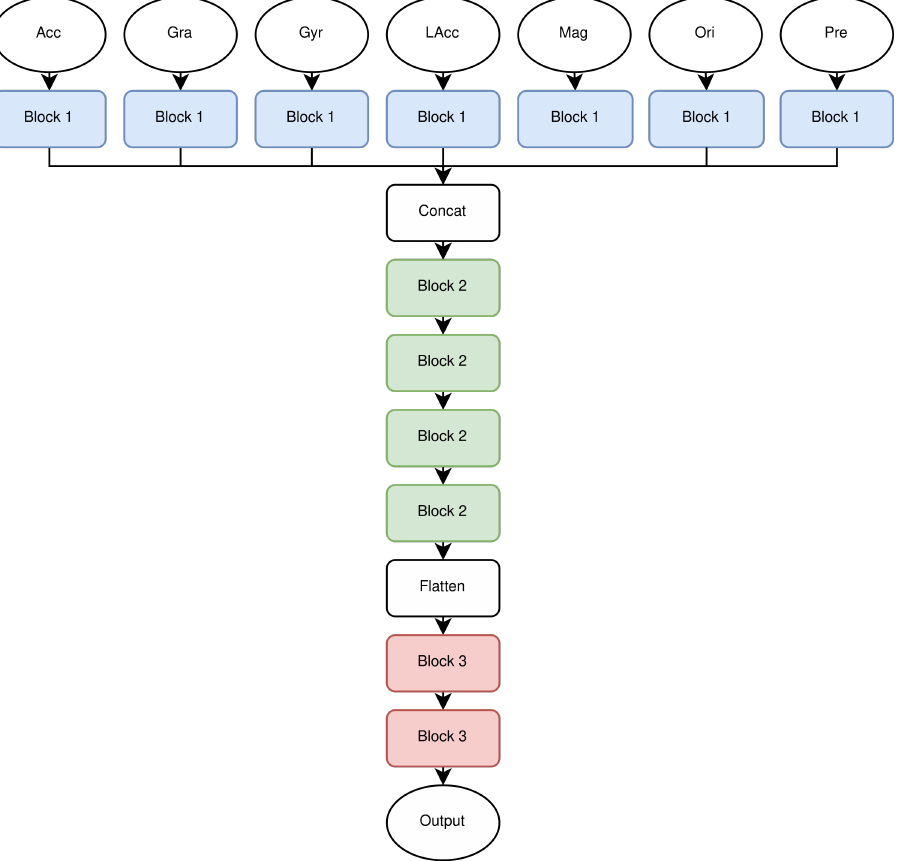
Figure 4. The architecture of the model. Each sensor modality had its own input, and the intermediate features were fused in the concatenation layer in the second